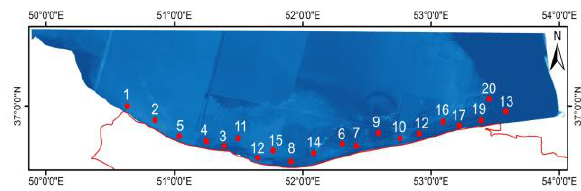
Figure 6 . Locations of sampling stations in Mazandaran coastline during post-monsoon, August 2022.